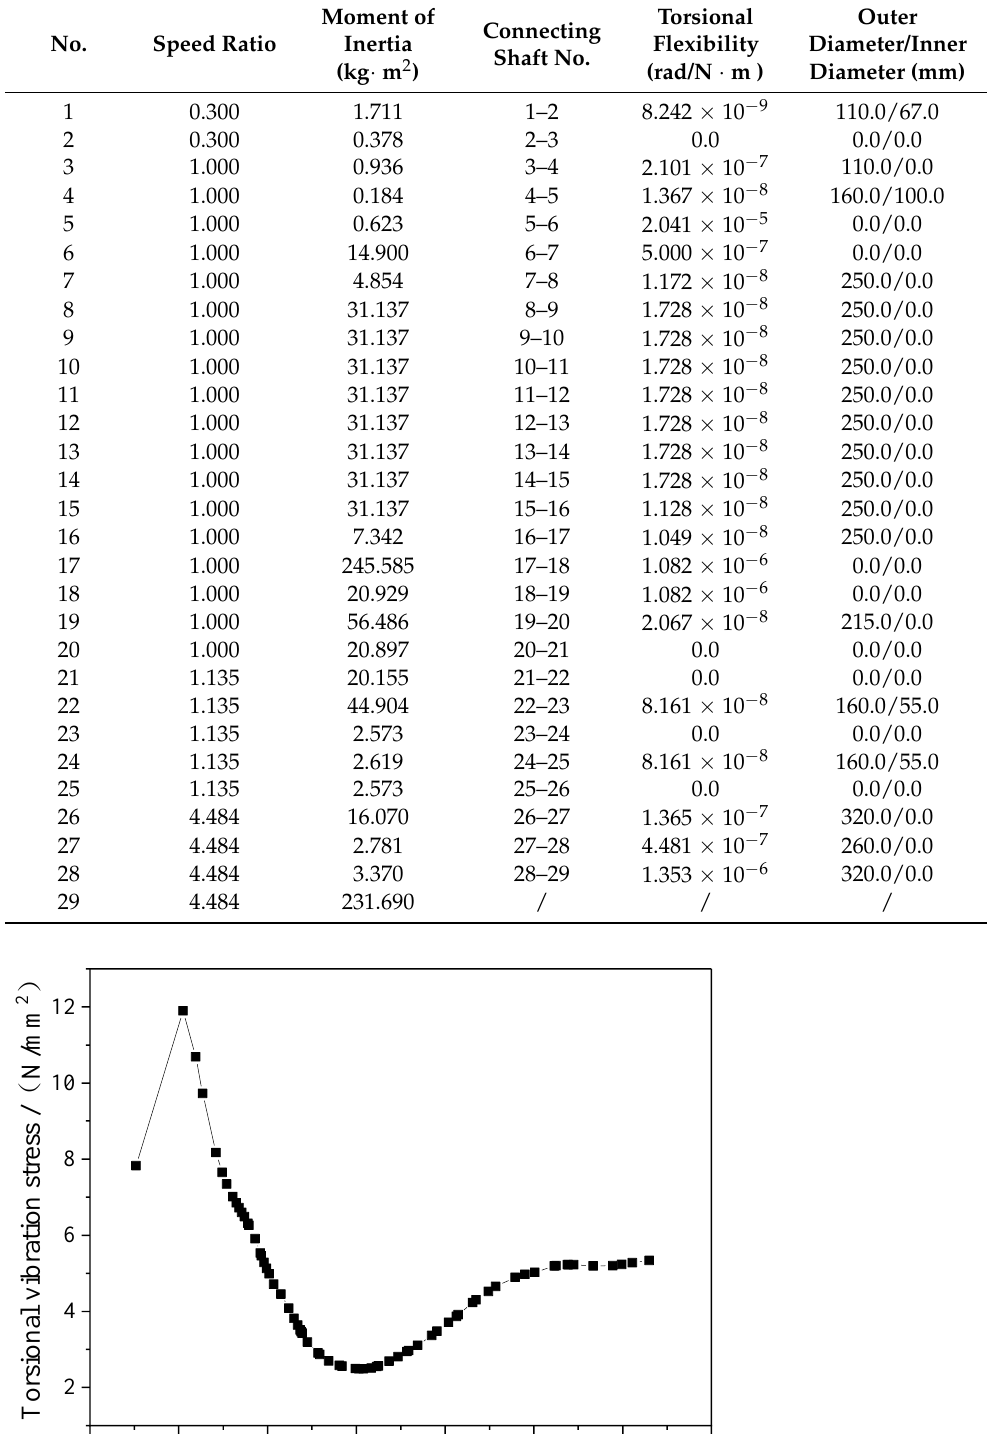
Table 2. Shafting equivalent parameters.